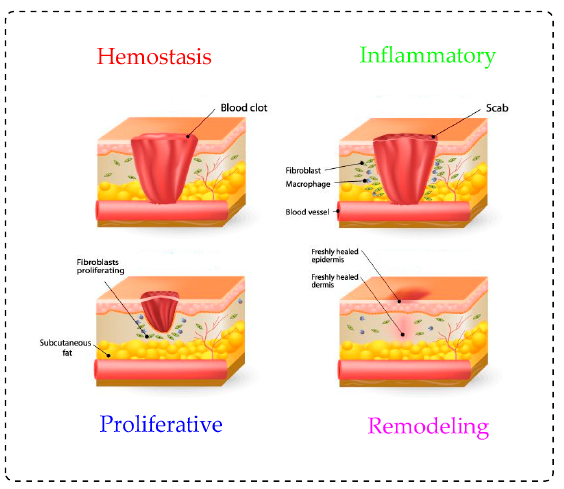
Figure 2. Schematic representation of wound healing stages.